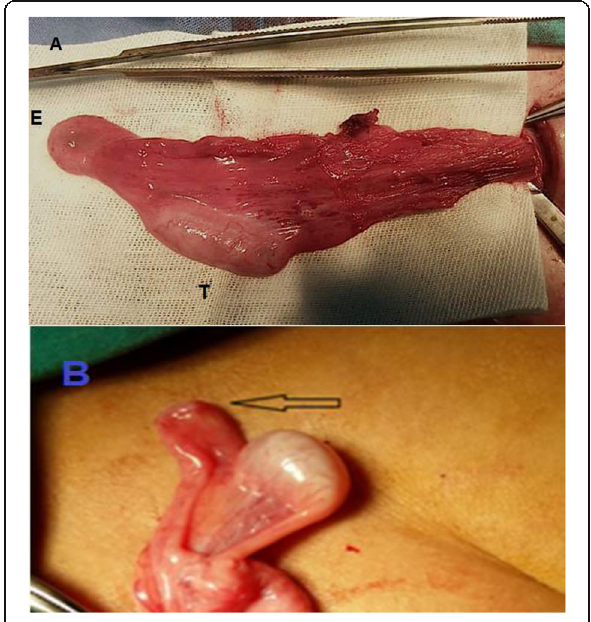
Fig. 5 a A complete separation of testis and epididymis. b Epididymal head and body detached from the